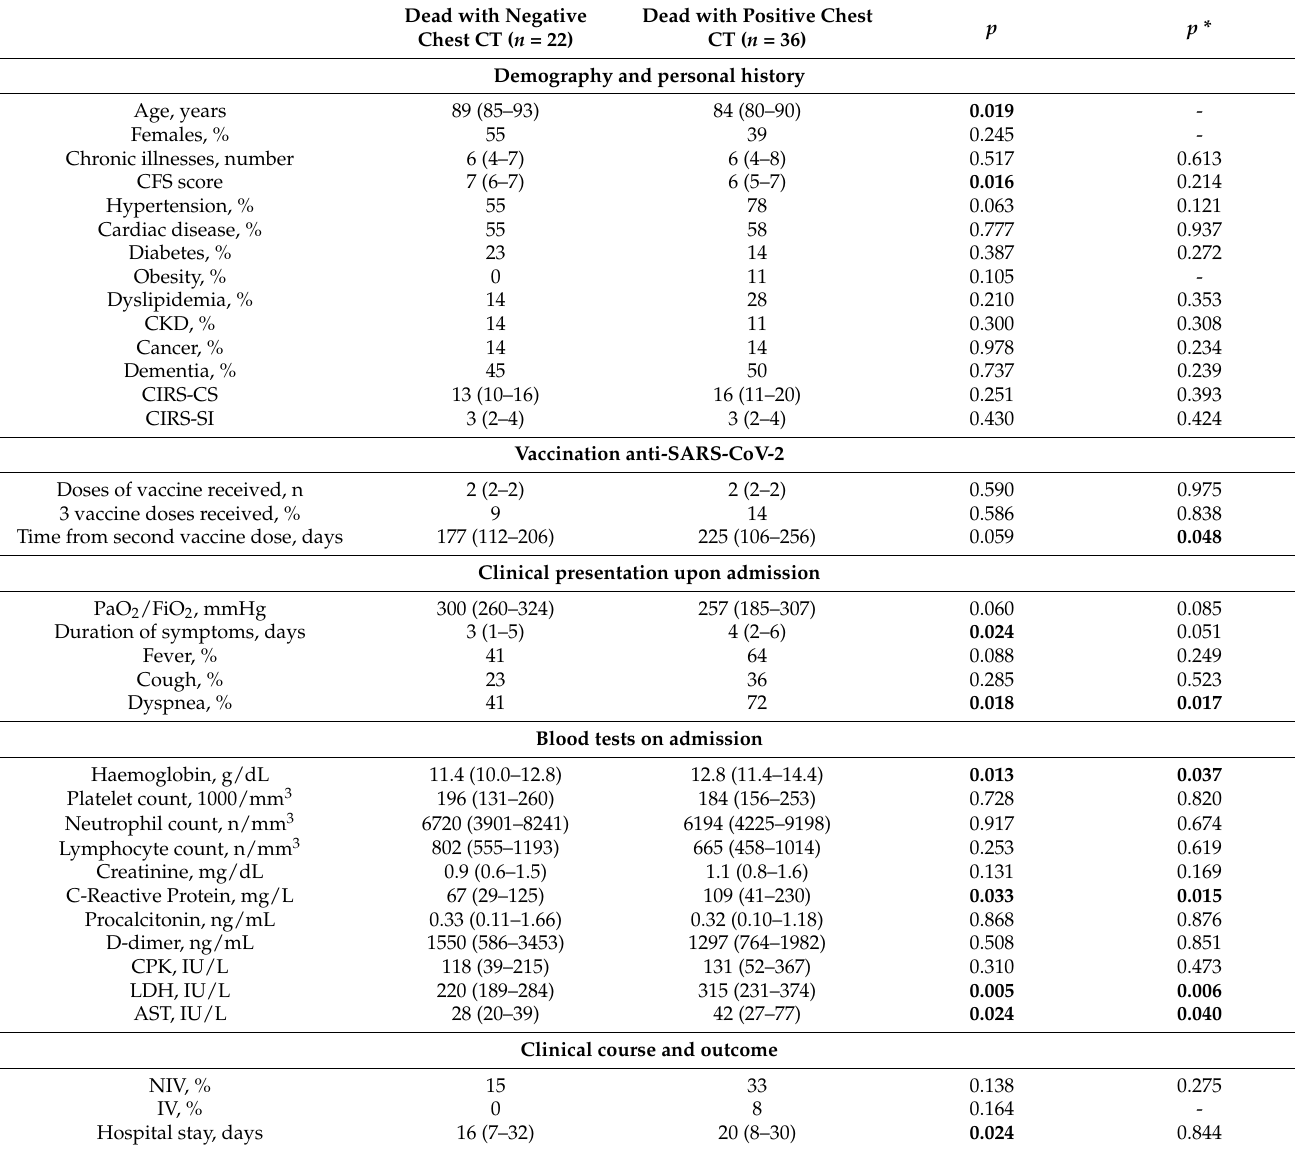
Table 3. Comparison of the clinical and laboratory characteristics of patients who died with COVID-19 breakthrough infection categorized according to chest CT